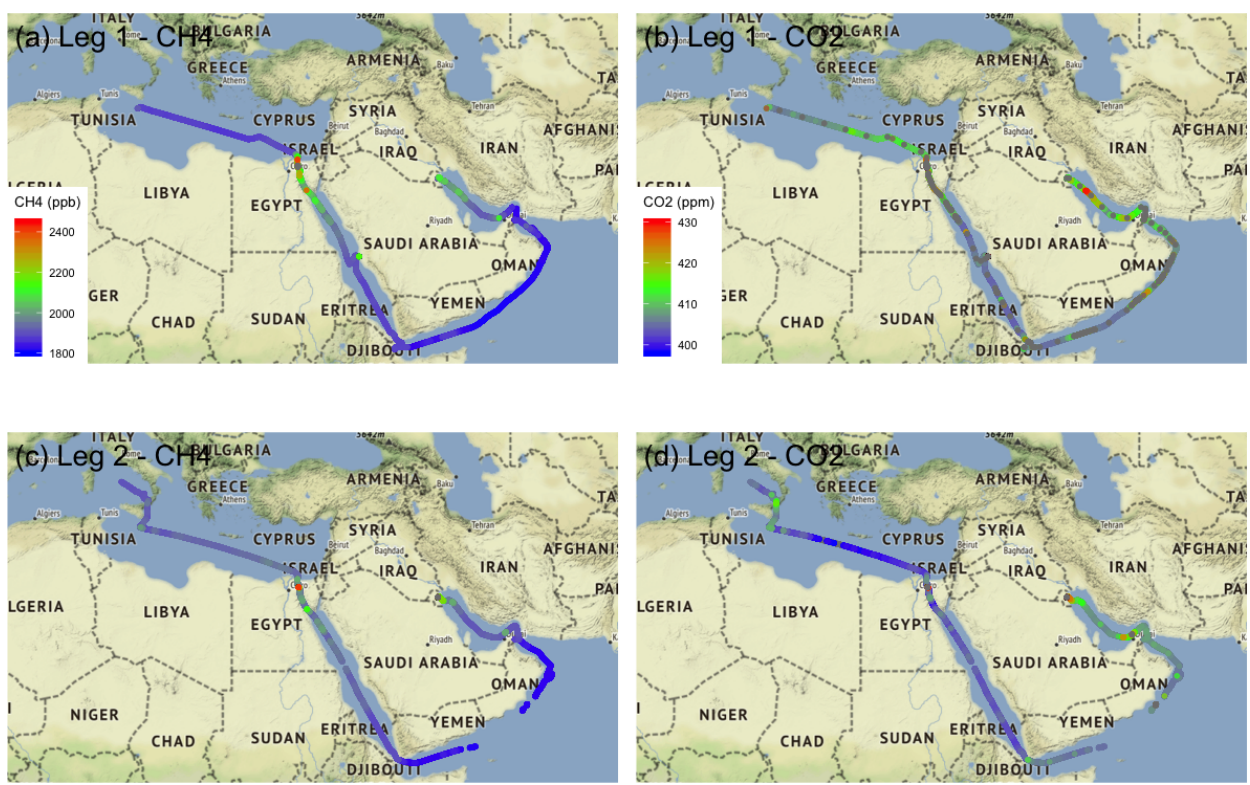
Figure 2. Measurements of CH 4 (a, c) and CO 2 (b, d) collected during Leg 1 from Toulon to Kuwait between 24 June and 31 July 2017 (a, b) and Leg 2 from Kuwait to Toulon between 3 August and 2 September 2017 (c, d) . Background map: © OpenStreetMap contributors 2021. Distributed under the Open Data Commons Open Database License (ODbL)